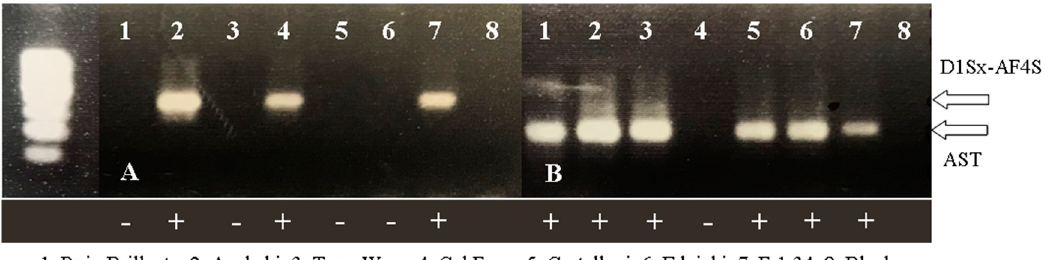
Figure 2. PCR results by electrophoresis in an agarose gel (1.5%) vs. phenotype data; ( A ) DlSx-AF4S PCR results. The ( + ) presence and ( − ) absence of male flowers from phenotype data; the DlSx-AF4S marker is present in varieties ‘Agakaki’, ‘Cal Fuyu’ and F.1-34 in agreement with the phenotype; ( B ) AST PCR results; ( + ) astringent fruits according to phenotype data and ( − ) non-astringent fruits (pollination constant non-astringent (PCNA)) according to phenotype data. The AST marker was present in all astringent varieties and absent in ‘Cal Fuyu’, a PCNA variety.